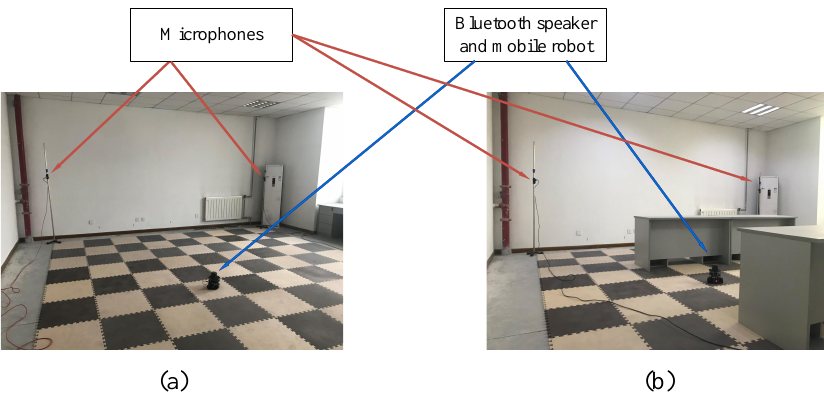
Figure 5. The experimental environment: ( a ) simple positioning scene; ( b ) complex positioning